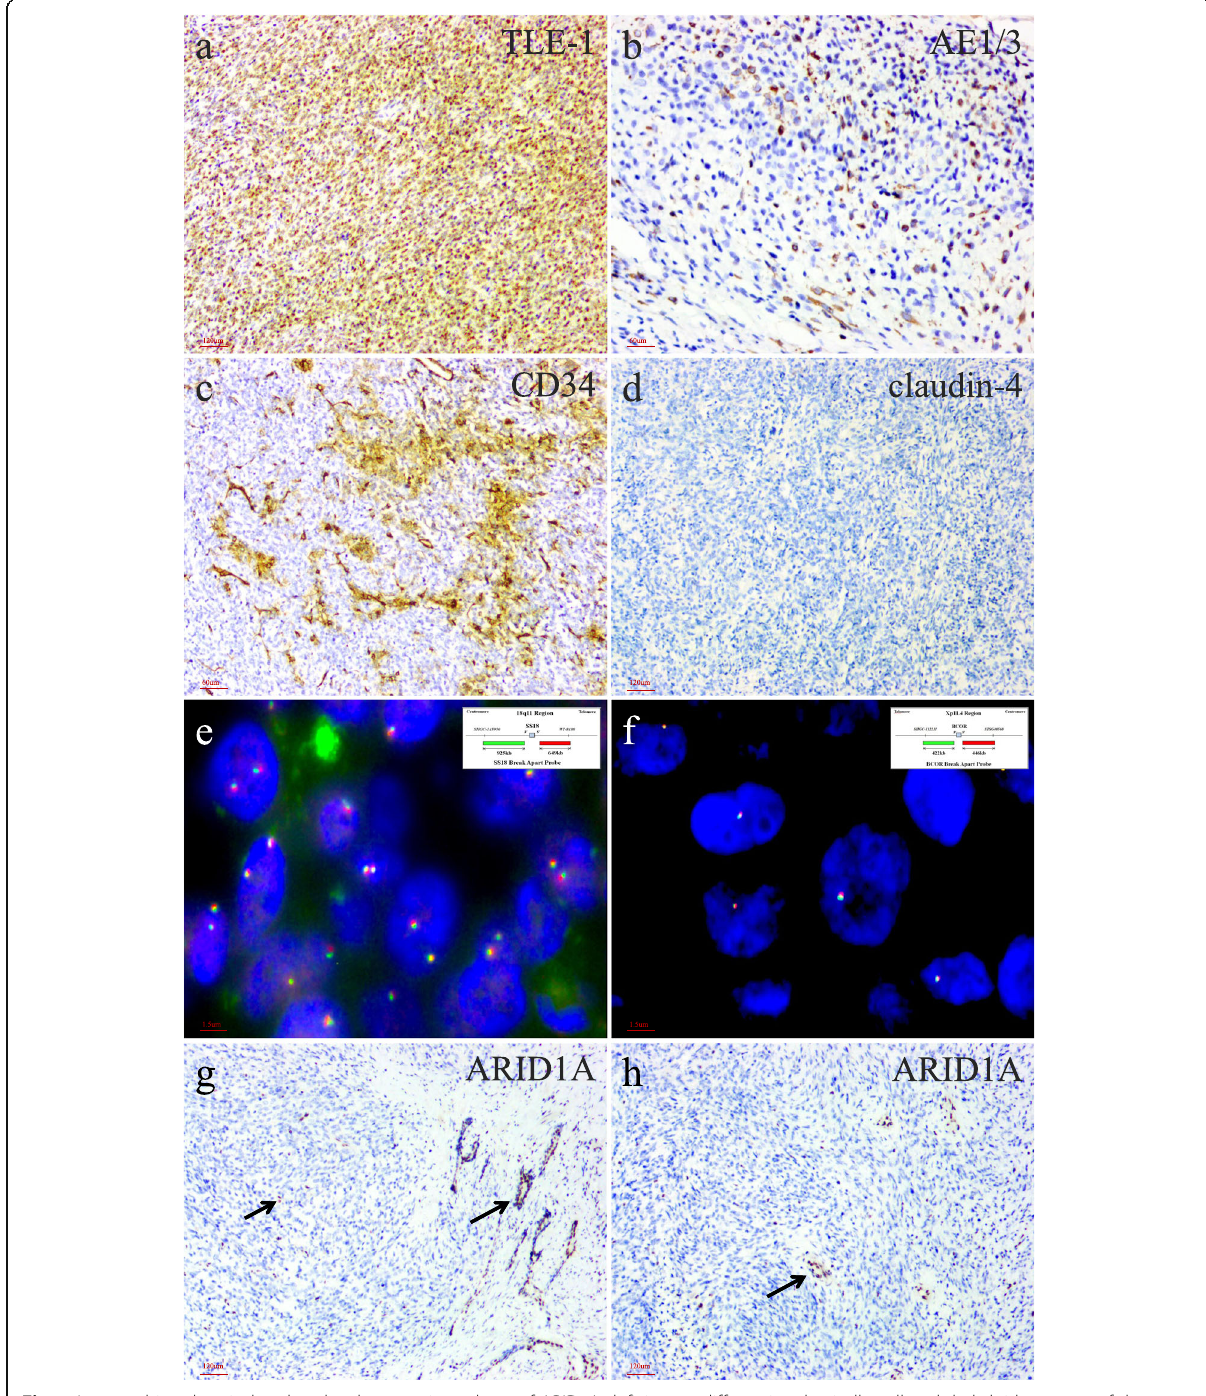
Fig. 4 Immunohistochemical and molecular genetic analyses of ARID1A deficient undifferentiated spindle cell and rhabdoid sarcoma of the prostate. The tumor cells are diffusely positive for ( a ) TLE-1 and focally positive for ( b ) AE1/3 and ( c ) CD34, and are negative for ( d ) claudin-4. Fluorescence in-situ hybridization analyses revealing negative for rearrangements of both the ( e ) SYT/SS18 and ( f ) BCOR loci ( Insets in e and f indicating schematic diagram of break-apart probes flanking SYT/SS18 and BCOR , respectively). ( g, h ) ARID1A immunohistochemistry exhibiting that tumor cells show complete loss of nuclear ARID1A expression with retained strong reactivity in the native prostatic glands and background stromal cells ( as indicated by arrows